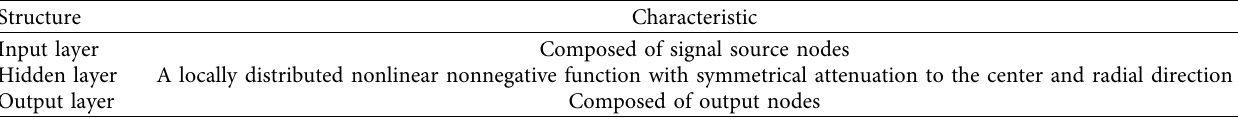
Table 1: Main structure of RBF neural network.